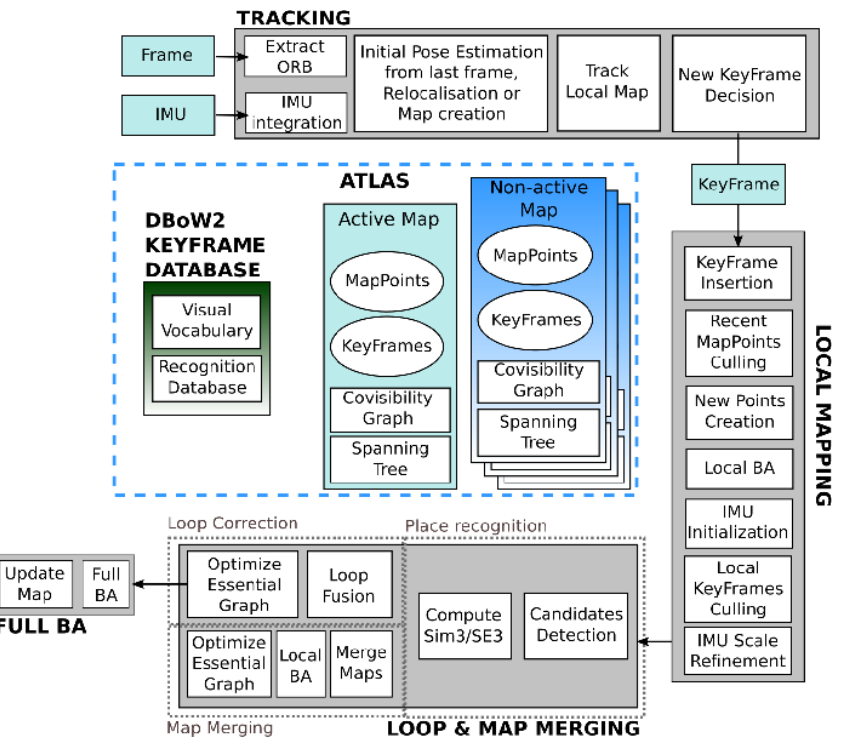
Figure 3. ORB-SLAM3 System Structure.